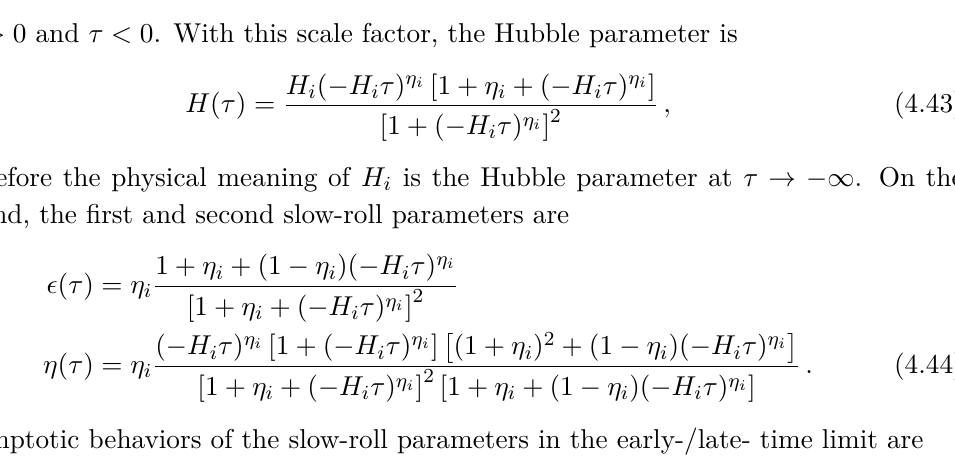
Figure 13 . The Hubble parameter and slow-roll parameters of the hybrid model (4.42). Here we have chosen η i = 0 . 1 for illustration. Clearly, the hybrid model is separated into two stages, with early time dominated by η -type and late time dominated by (cid:15)